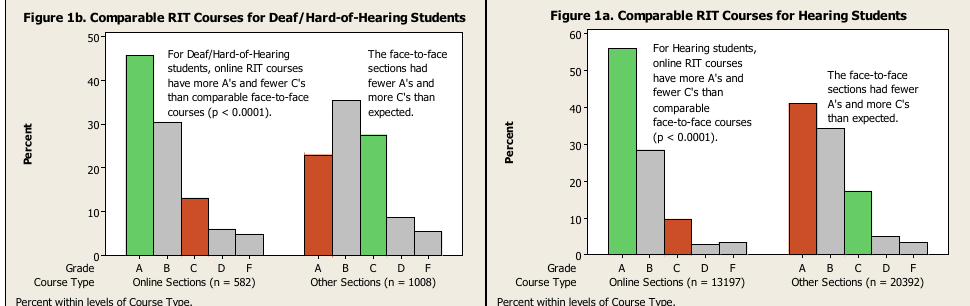
Figure 1. Grade distributions in comparable online and face-to-face